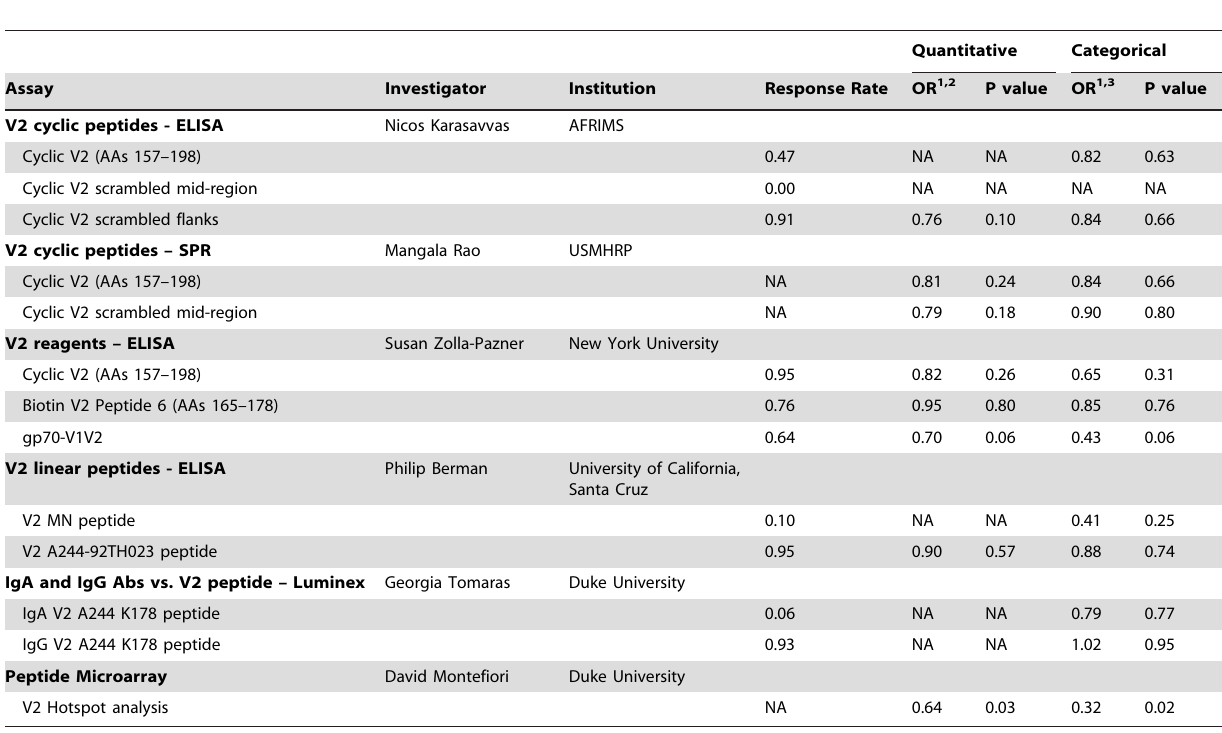
1 Estimated odds ratios are computed using a logistic regression model accounting for the sampling design and adjusting for gender and behavioral risk score, as described in Haynes et al [2]. 2 Estimated odds ratio per one standard deviation increment in the immune biomarker; not available (NA) if response rates, when applicable, are less than 50%. For example, the OR of 0.70 (ELISA binding to gp70-V1V2) means that for every higher SD value, the rate of infection is reduced by 30%, while the OR of 0.43 means that vaccinees with responses in the upper third had an infection rate 57% lower than vaccinees with responses in the lower third. 3 Estimated odds ratios comparing subgroups defined by high vs. low responses except for two (IgA V2 A244 K178 and V2 MN) which compare positive vs. negative response and one (biotin V2 peptide 6) which compares high vs. negative; not available (NA) for Cyclic V2 scrambled mid-region (ELISA) which has no positive responses.